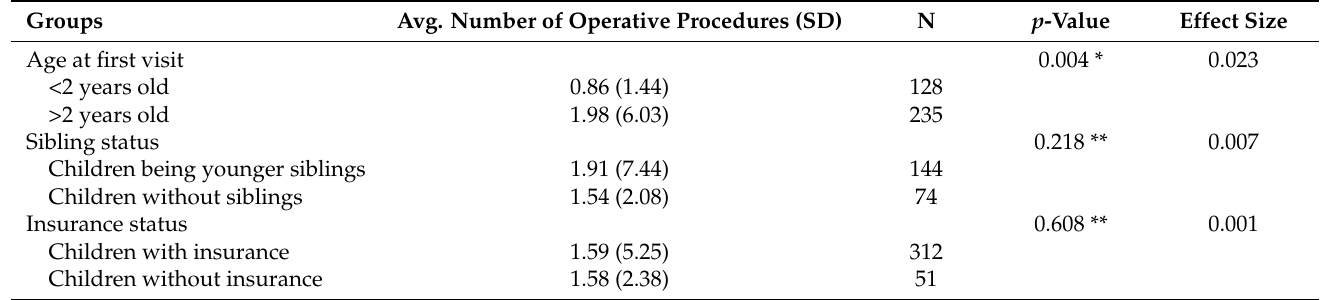
Table 4. Difference in the number of operative procedures across various groups (multiple compar- isons were adjusted using Bonferroni